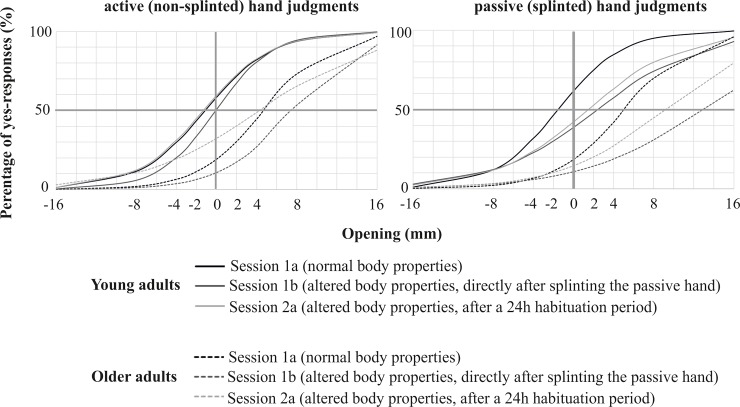
Logistic fits on proportions of yes-responses for passive hand judgments.The graph depicts the fitted proportions for both age groups and sessions as a function of aperture width. The point where the trend lines cross the horizontal grey line indicates the 50% perceived action boundary. Data below the line indicate a preference for “not able to fit”, whereas data above the line indicate preference for “able to fit”.